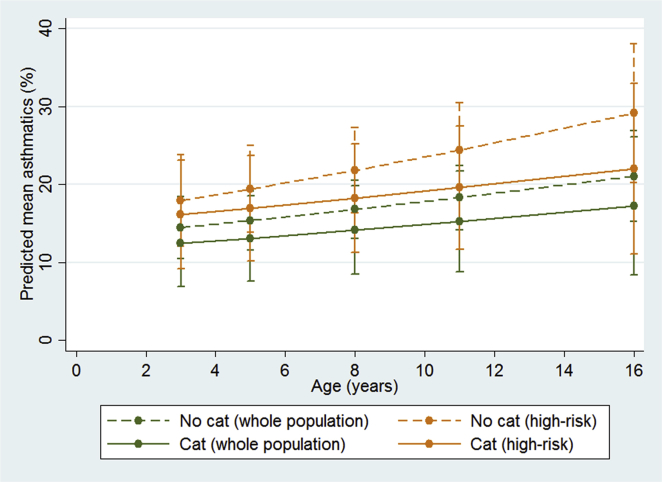
Prototypical longitudinal trajectory of asthma development among children who owned a cat and those who did not own a cat in early life. Predicted value of mean response is shown in graphical format along with 95% CIs.